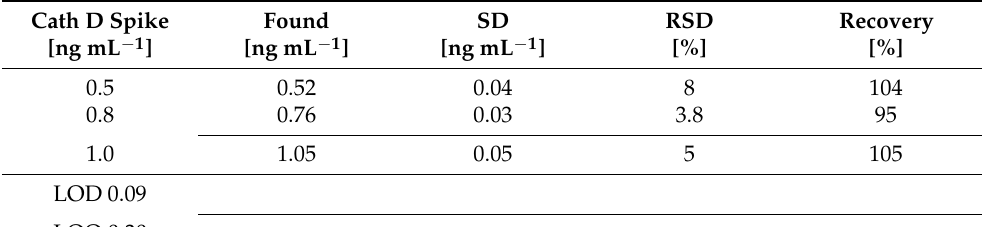
Table 5. Precision and recovery of Cath D determination using the biosensor with an Ag/Au chip and two-paint separating polymer.